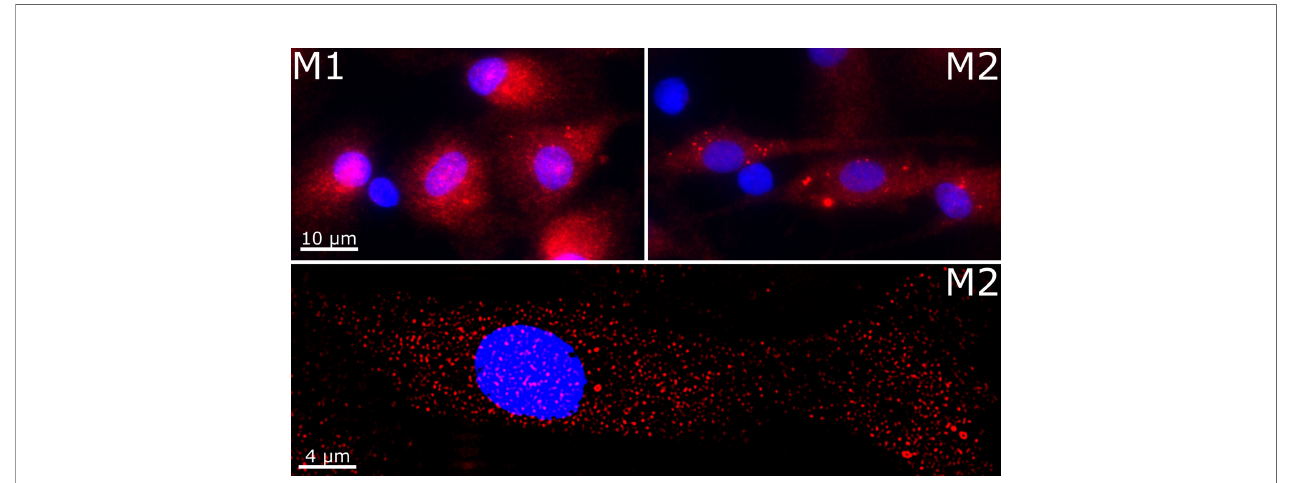
FIGURE 3 | Cellular localization of VISTA in M1 and M2 macrophages. VISTA was stained in polarized macrophages with a monoclonal mouse anti-human VISTA antibody and Alexa Fluor 594-coupled secondary antibody. Lower panel shows the image deconvolution of a